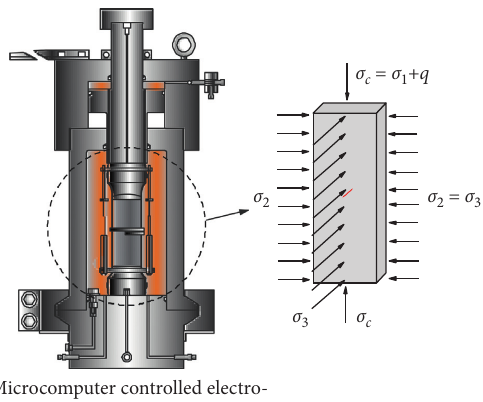
Figure 10: Comparison of Poisson’s ratio and dry density and friction angle of mortar to granite (data from Liu et al.